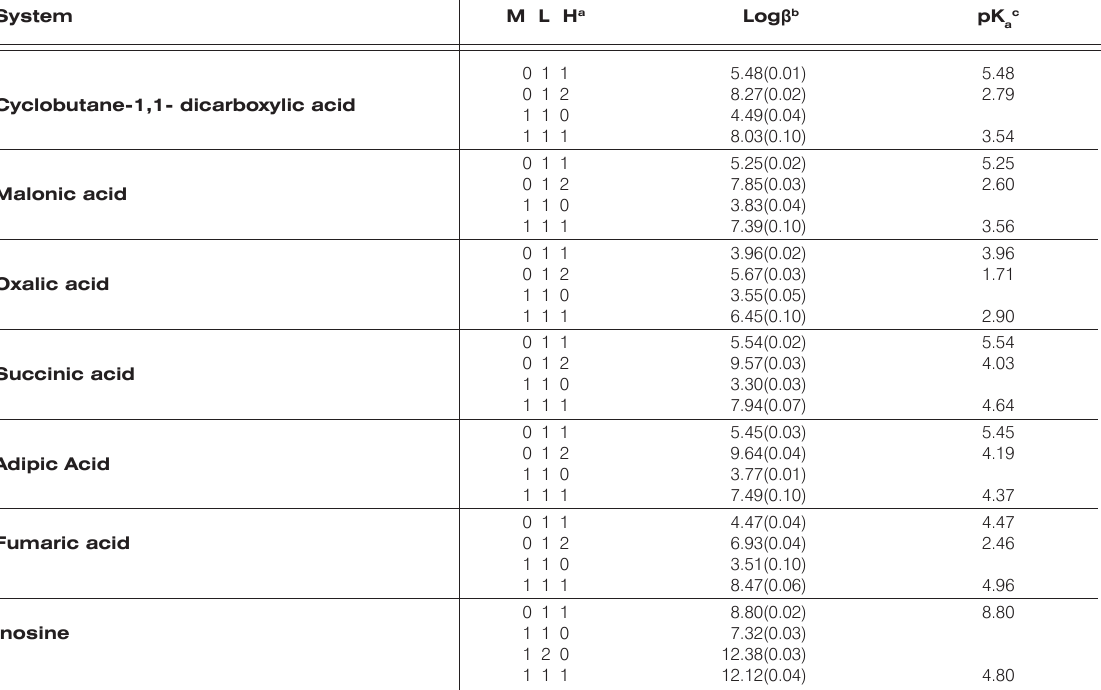
O) ] 2+ with dibasic acids and inosine at 25°C and 0.1 M ionic 2 2